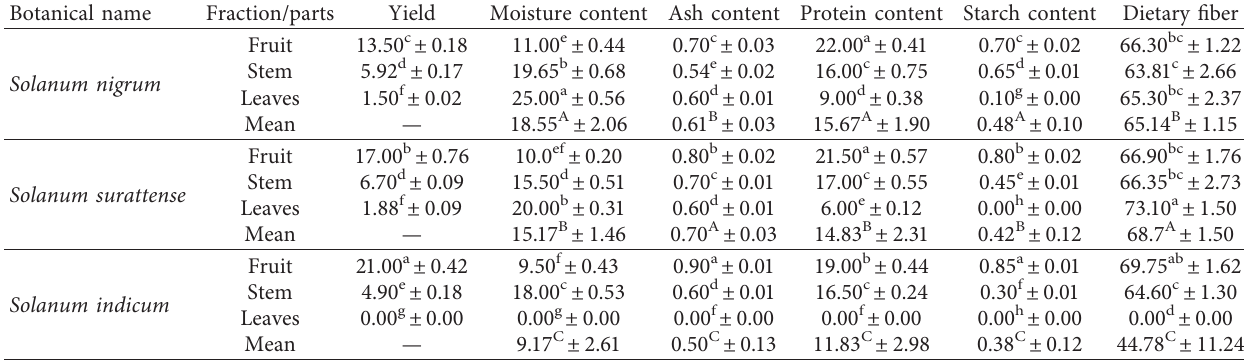
Table 1: Hydrocolloid yield and proximate composition (% age ± SD) of aerial parts of S. nigrum, S surattense , and S. indicum using the water extraction method. Botanical